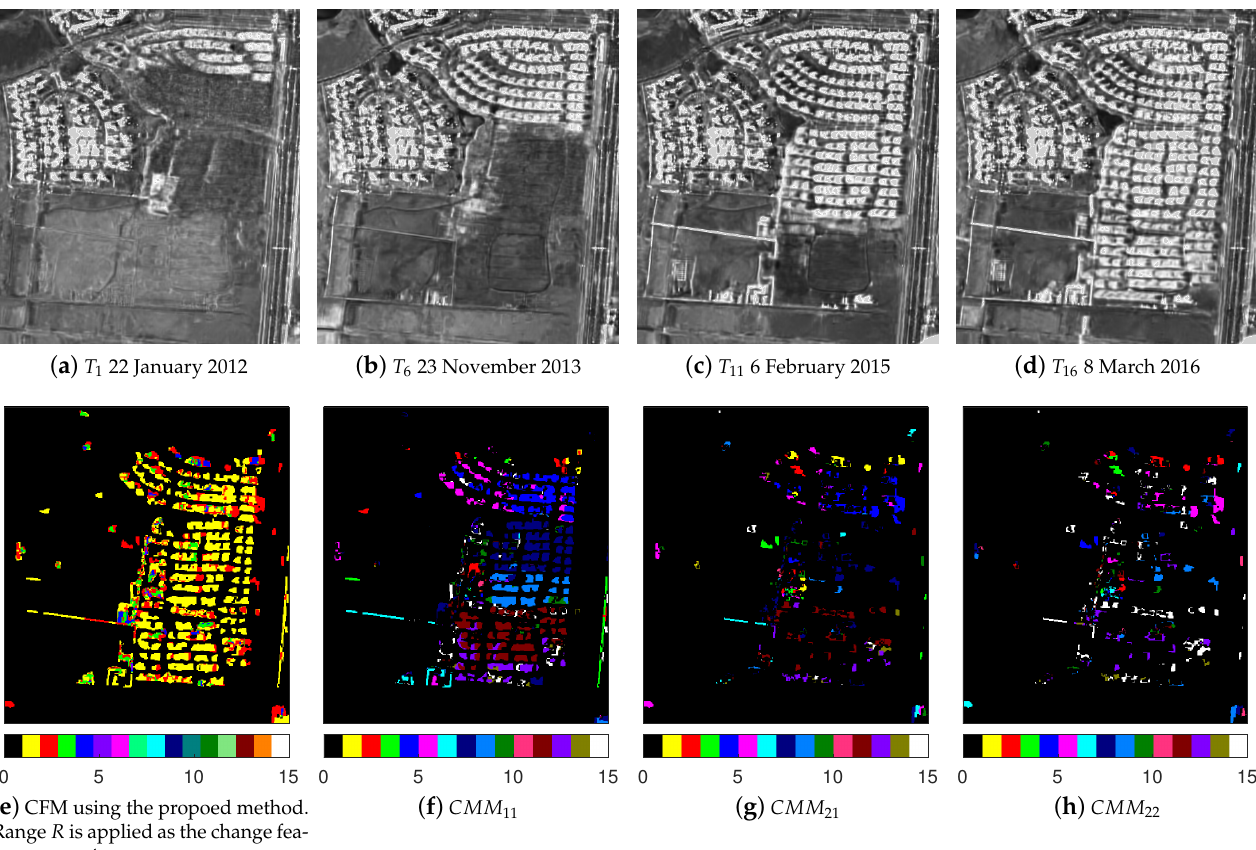
Figure 7. Four images of original data 2 (after denoising) are illustrated in the first line. The second line displays the CFM and CMMs of data 2. To conserve space, we only illustrate CMMs of objects whose CF ≤ 2 because very few objects change more than three